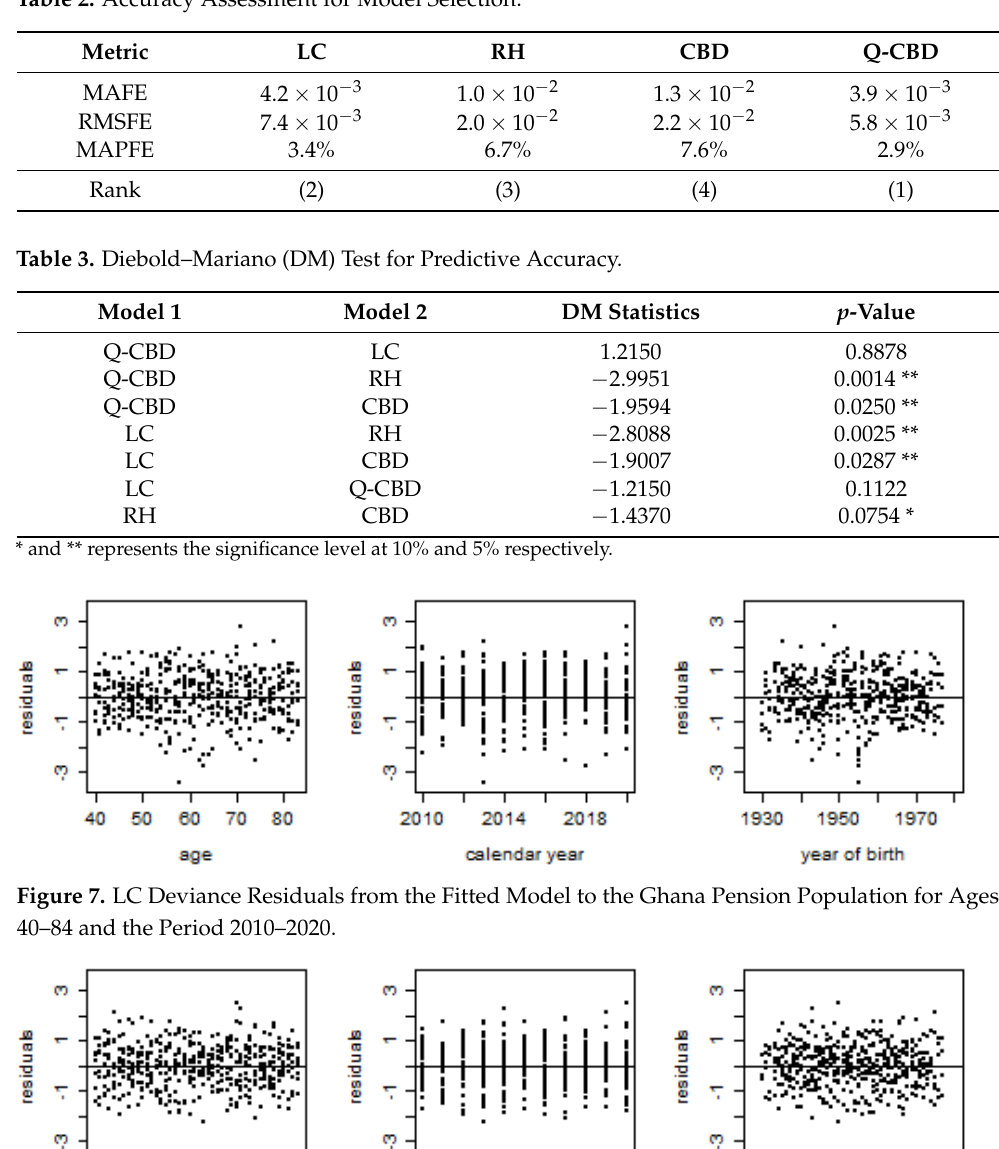
Table 2. Accuracy Assessment for Model Selection.